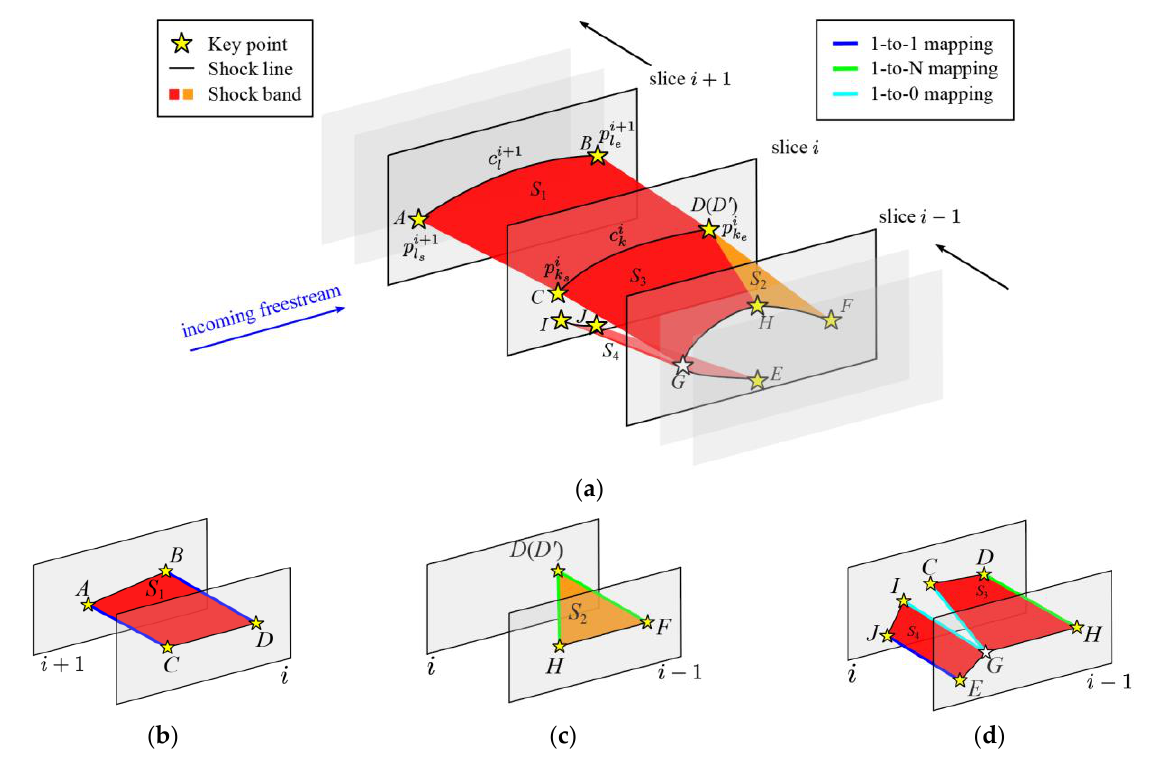
Figure 6. Schematic diagram of the mapping strategy: ( a ) key points, shock lines, and shock bands in or between adjacent slices. ( b – d ) the local topologies of ( b ) 1-to-1 mappings, ( c ) 1-to-N mapping, and ( d ) 1-to-0 mapping.